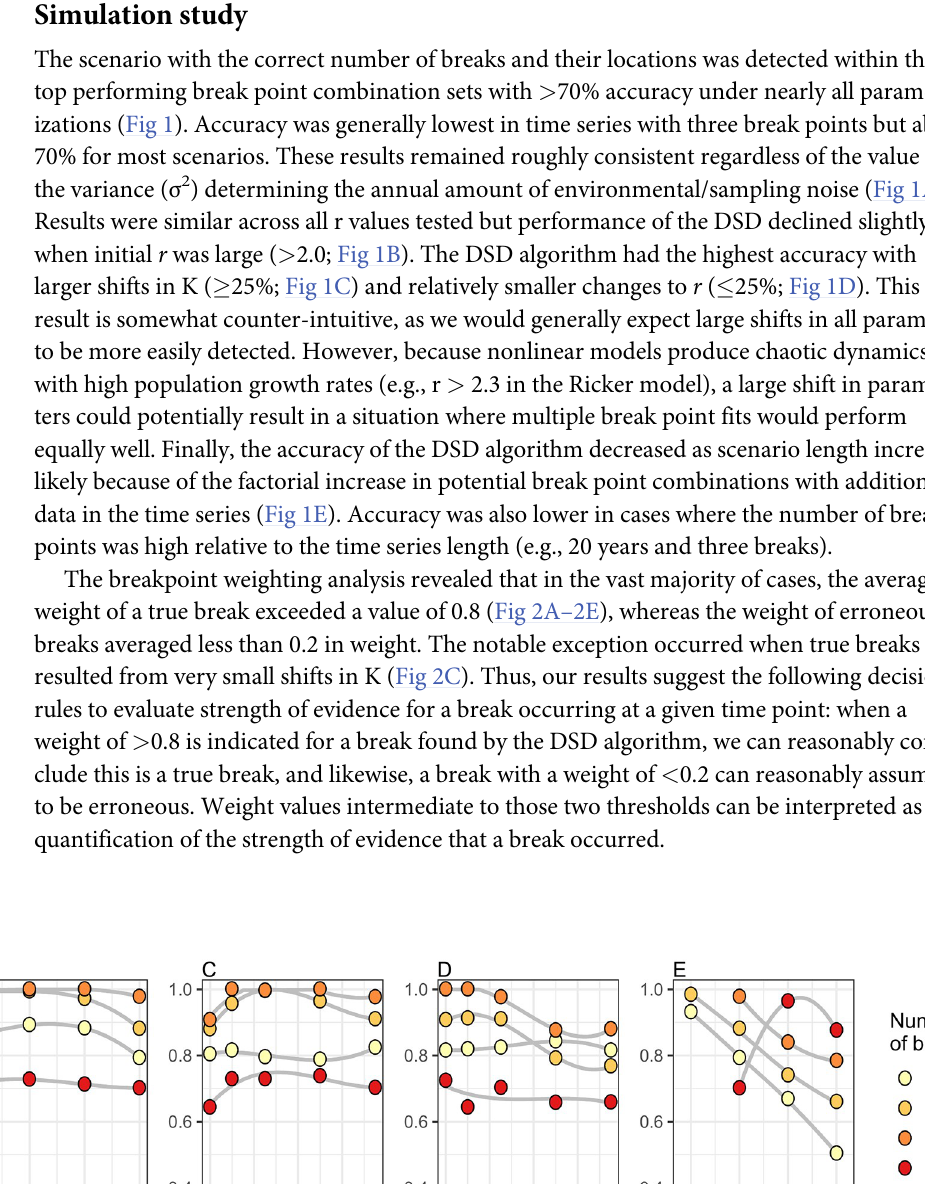
PLOS Computational Biology | https://doi.org/10.1371/journal.pcbi.1007542 January15,